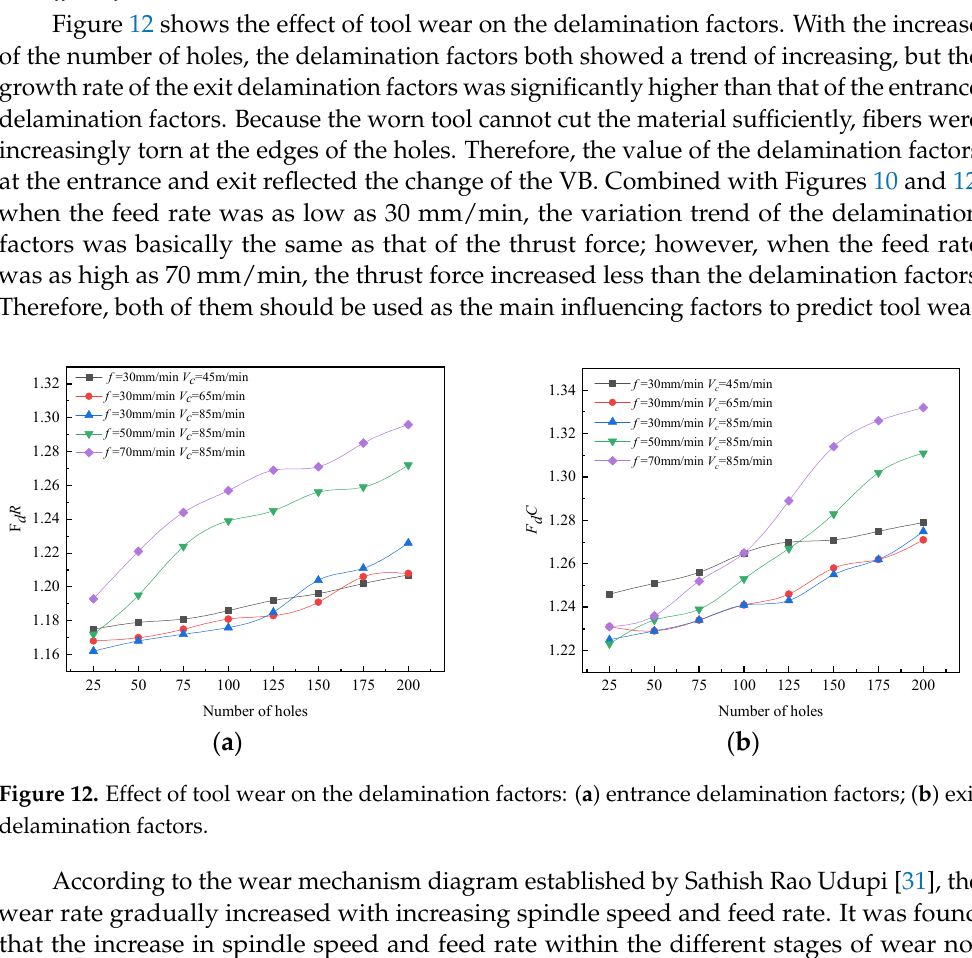
Figure 11. Effect of tool wear on the vibration amplitude: ( a ) different cutting speeds; ( b ) different feed rates.